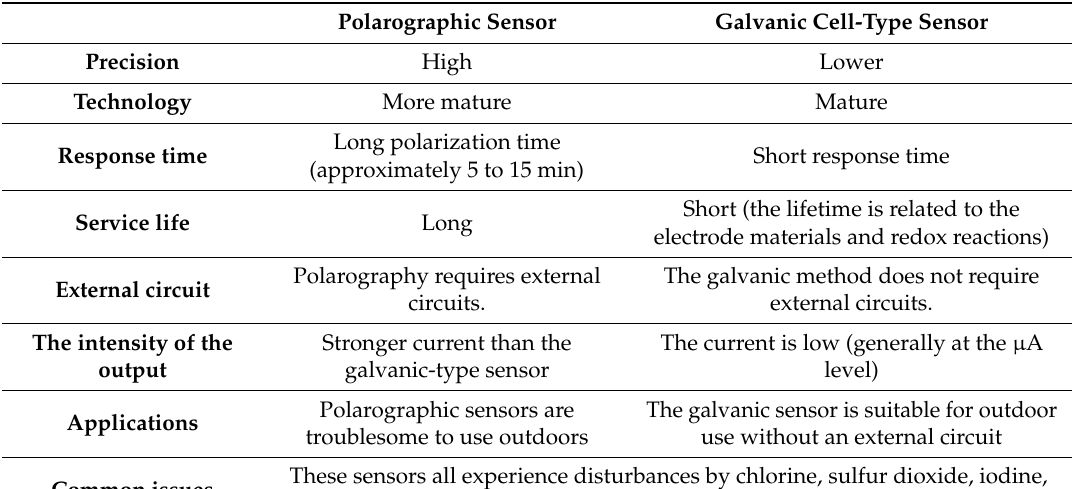
Table 2. Comparison of polarographic and galvanic dissolved oxygen